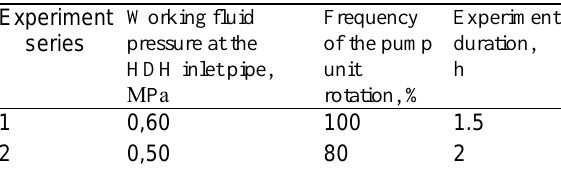
Table 5. Initial data for the